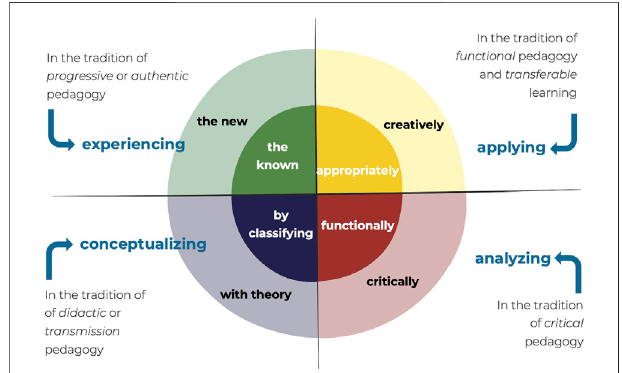
FIGURE 7 | Multiliteracies pedagogy: recruiting and supplementing traditions of educational practice (Cope and Kalantzis in review).